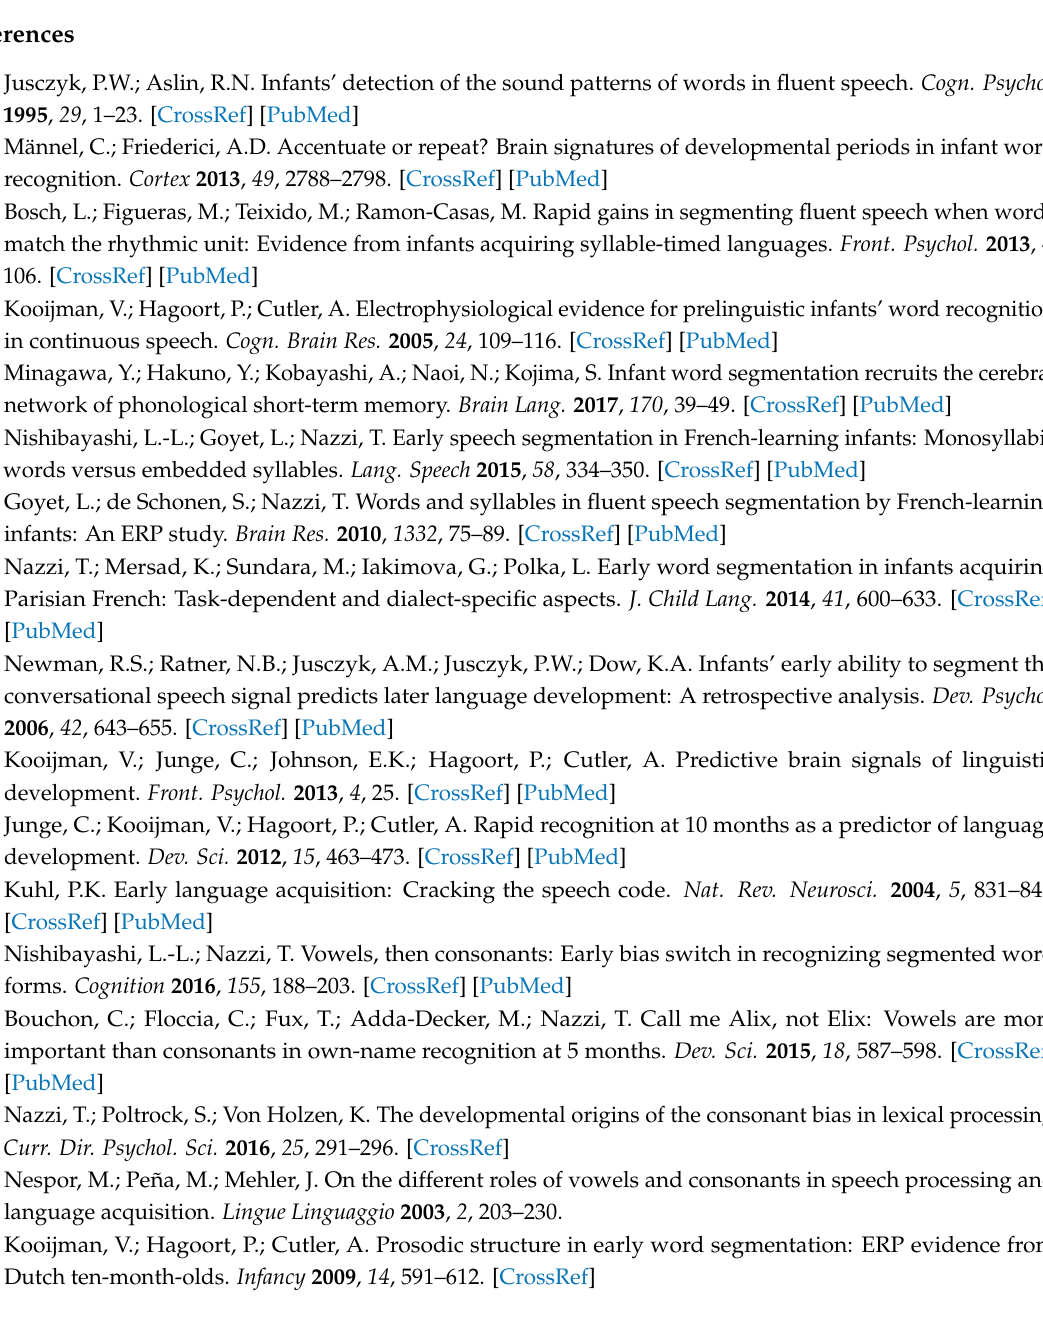
Table S1: Summary of Test Phase stimuli for one counterbalancing version, Table S2: Output of a mixed effects model for total production growth in relation to Test Phase response Polarity, Table S3: Output of a mixed effects model for total production growth in relation to mispronunciation